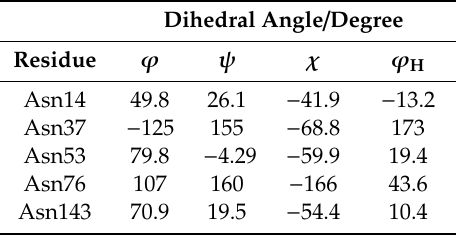
Table 1. Dihedral angles (degrees) of Asn residues in the experimentally determined structure.